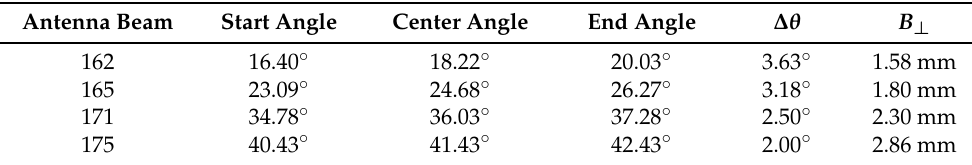
Table 1. GF-3 radar parameters.